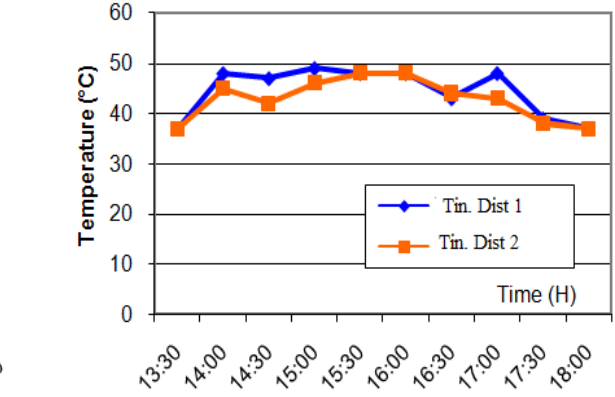
Figure 6a. variation of the glazing temperature (outside face)